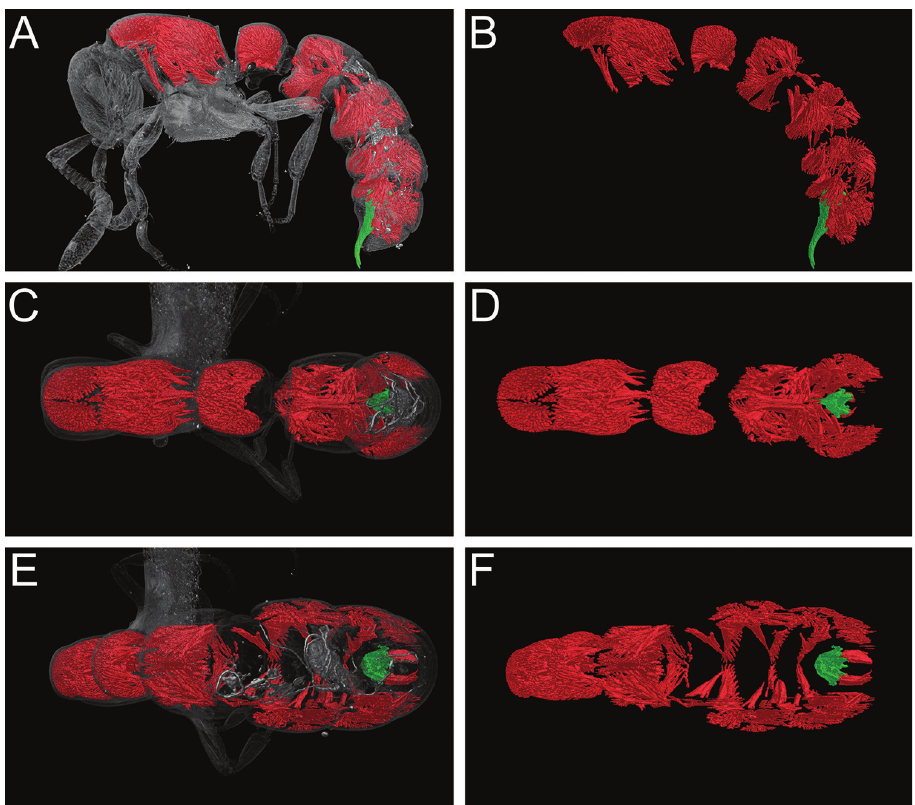
Figure 15. Still images of 3D model of full body of Zasphinctus sarowiwai sp. n. holotype worker (CASENT0764654). False-colour volume rendering of segmented mesosoma and metasoma musculature (red) and sting apparatus (green) superimposed on semi-transparent surface model ( A, C, E ) or stand- alone ( B, D, F ). A, B Body in profile view C, D Body in dorsal view E, F Body in posterodorsal